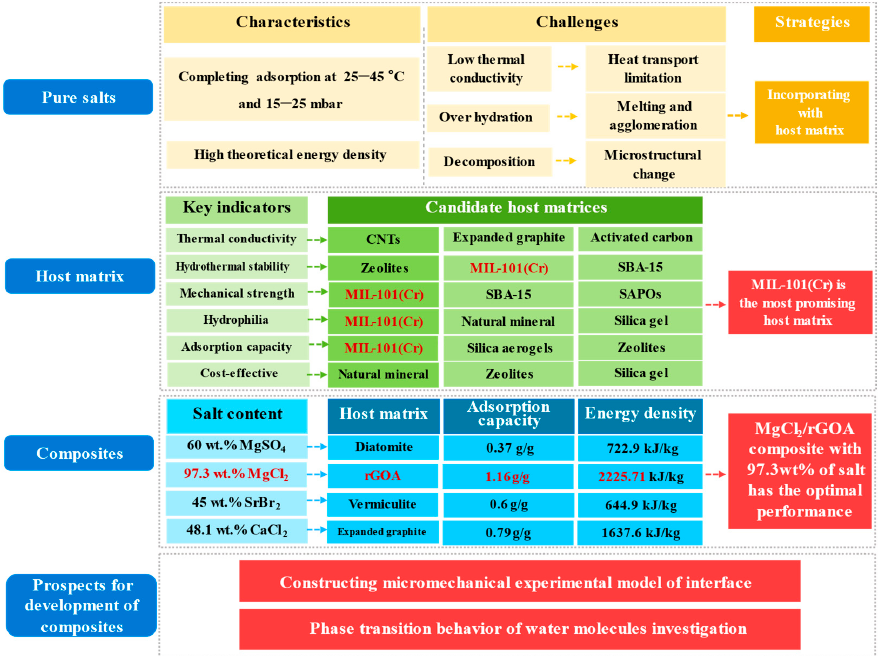
Figure 7. The major contents of this review of salt hydrate adsorption-based TCES materials: Dark blue in the leftmost column indicates the subjects studied in Section 2 and 3. Light yellow indicates the characteristic and challenges on pure salt. Dark yellow indicates the main strategy adopted to face the challenge of pure salt. Light and dark green indicates key indicators of the host matrix as well as candidates, respectively. Blue in the middle column indicates the adsorption/desorption performance on composite materials. Dark red indicates the main conclusions reached and the future direction of composites